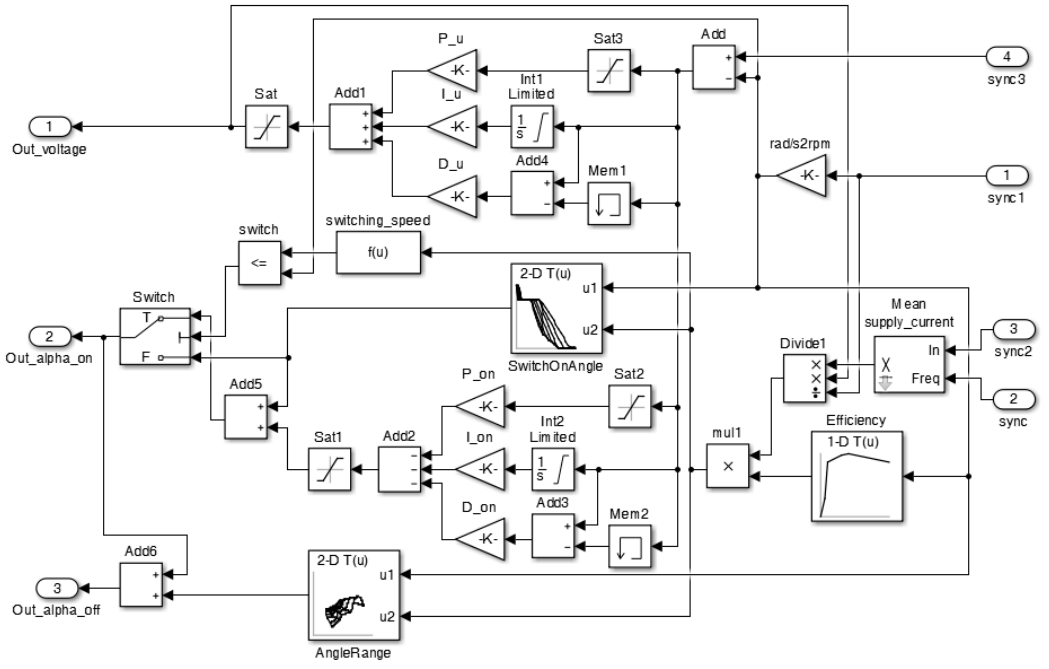
Figure 8. The regulator model in MATLAB Simulink software.